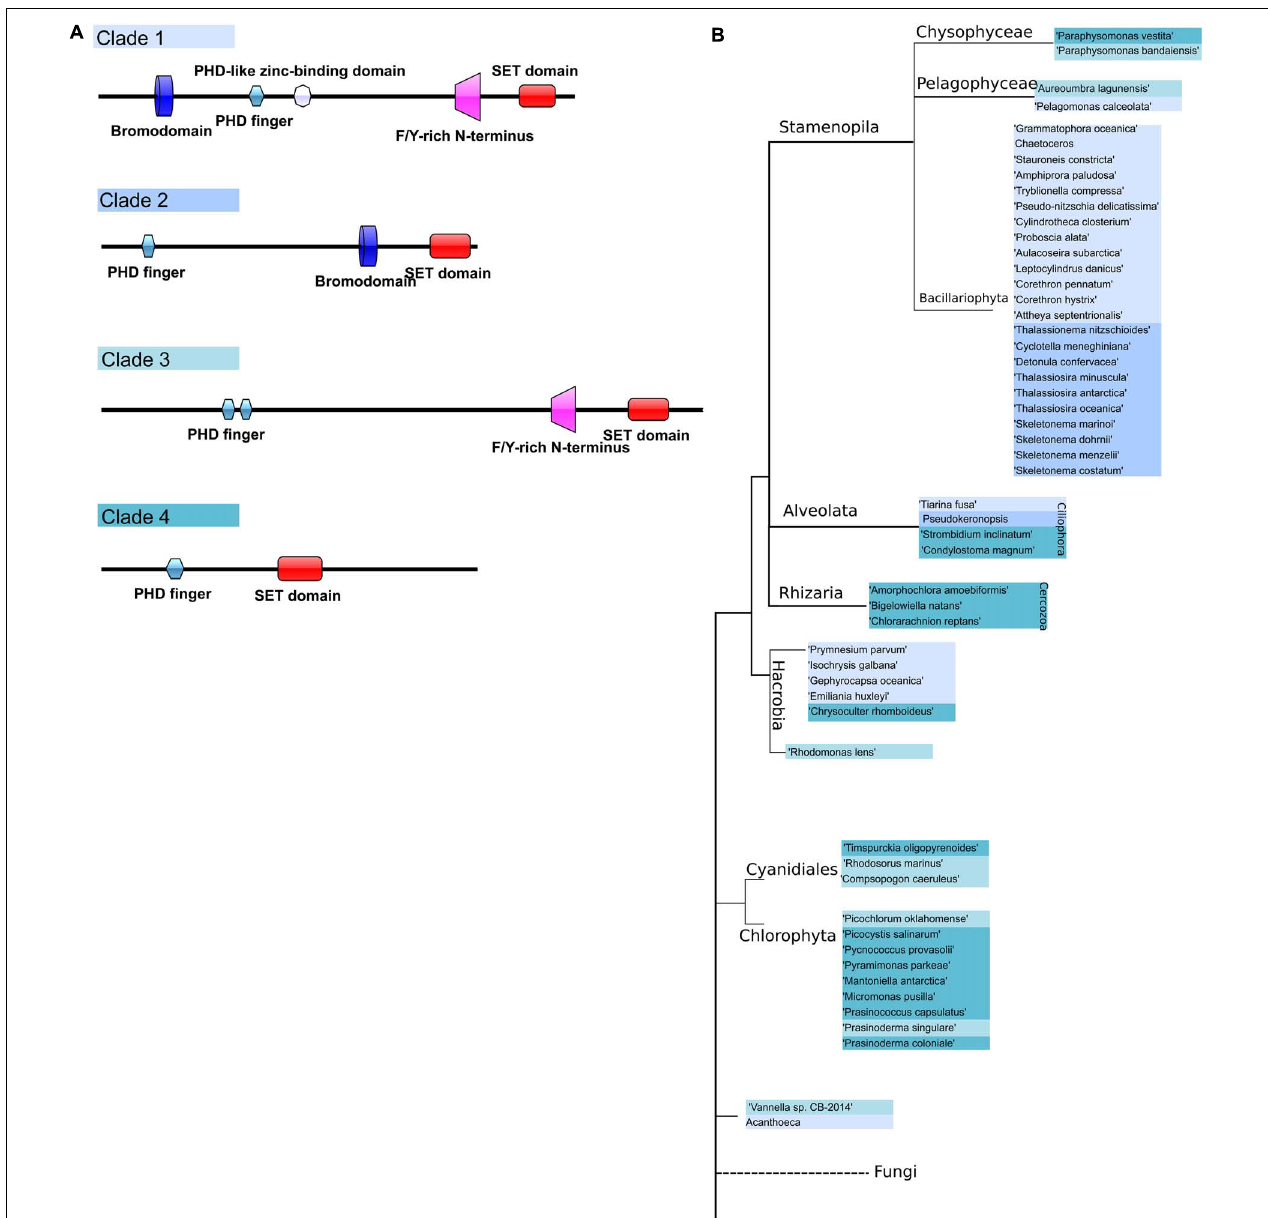
FIGURE 5 | Domain architecture of Trithorax homologs in microalgae and their phylogenetic distribution. (A) Scheme representing the different groups of TrxG protein domain structures, (B) TrxG group distribution in a phylogenetic tree.